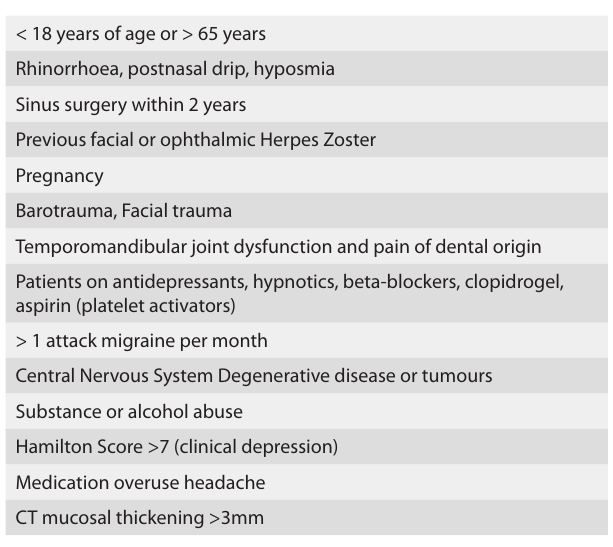
Table 2. Study exclusion